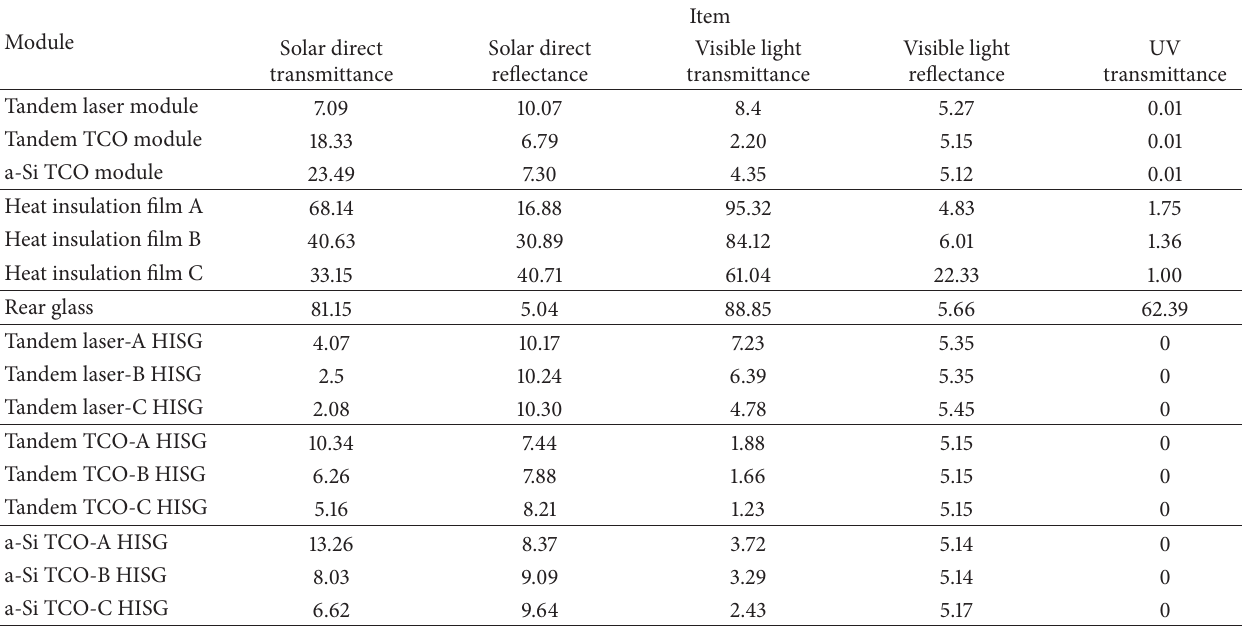
Table 1: Optical properties of each component and HISGs.